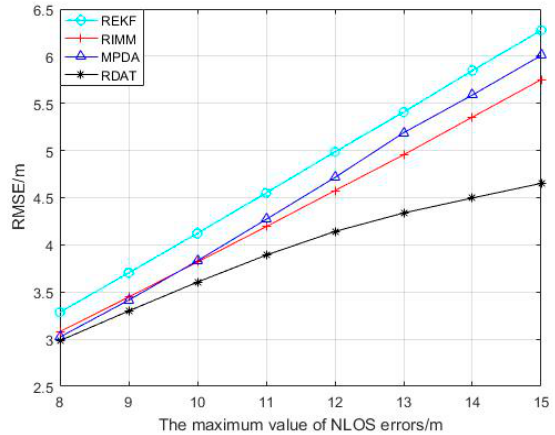
Figure 8. Performance comparison between RIMM, REKF, MPDA, and RDAT with di ff erent maximum (cid:16) (cid:17) value of NLOS error, where P NLOS = 0.5, N 0,1 2 and U ( 0,14 )